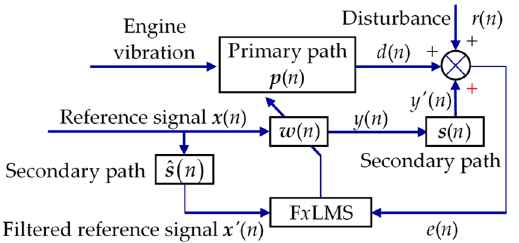
Figure 4. F x LMS adaptive feedforward control block diagram.